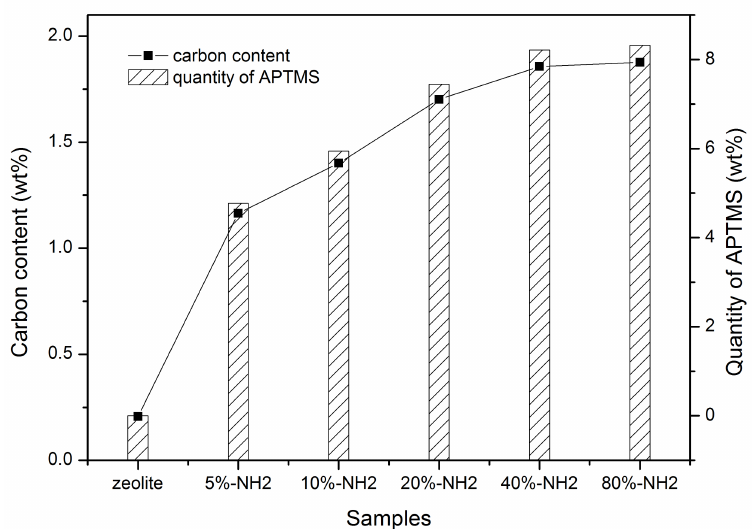
Figure 1. Total carbon contents of zeolite and amino functionalized zeolite samples and real quantities of 3-aminopropyltrimethoxysilane (APTMS) loaded in the